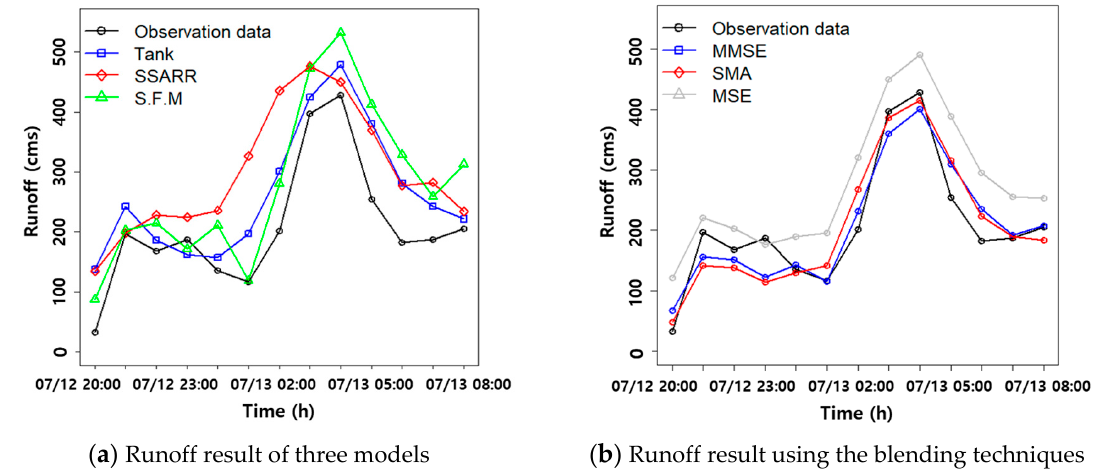
Figure 13. Runoff hydrograph using the maximum rainfall ensemble.